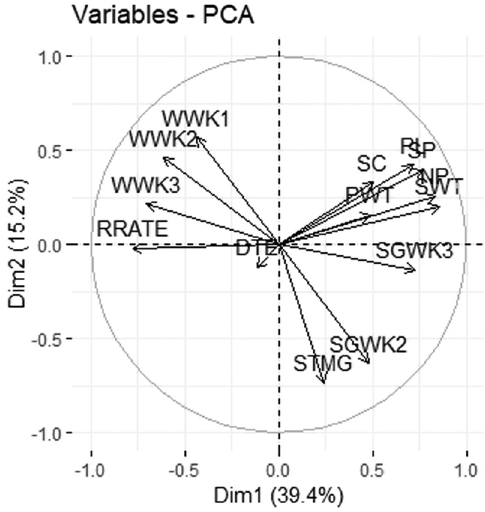
Figure 4: The contribution of various variables among 60 cowpea accessions screened for drought tolerance. SGK1 – stem